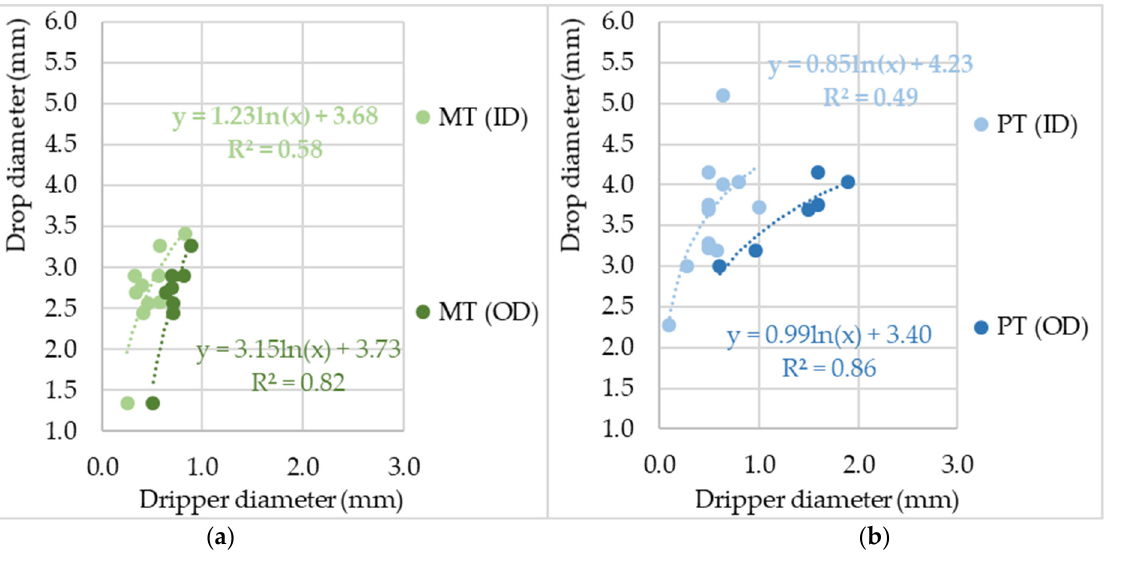
Figure 2. The influence of MT ( a ) and PT ( b ) drippers OD and ID on the drop diameter. Note: drippers whose corresponding drop diameter sizes were modified by the action of air, vibrations and inserted threads, and drops and drippers whose diameters were given in a range, were excluded from the analysis.